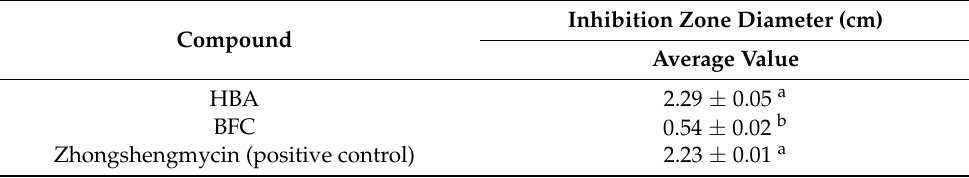
Table 1. Inhibition effect of three fungicides against A. avenae subsp. citrulli .